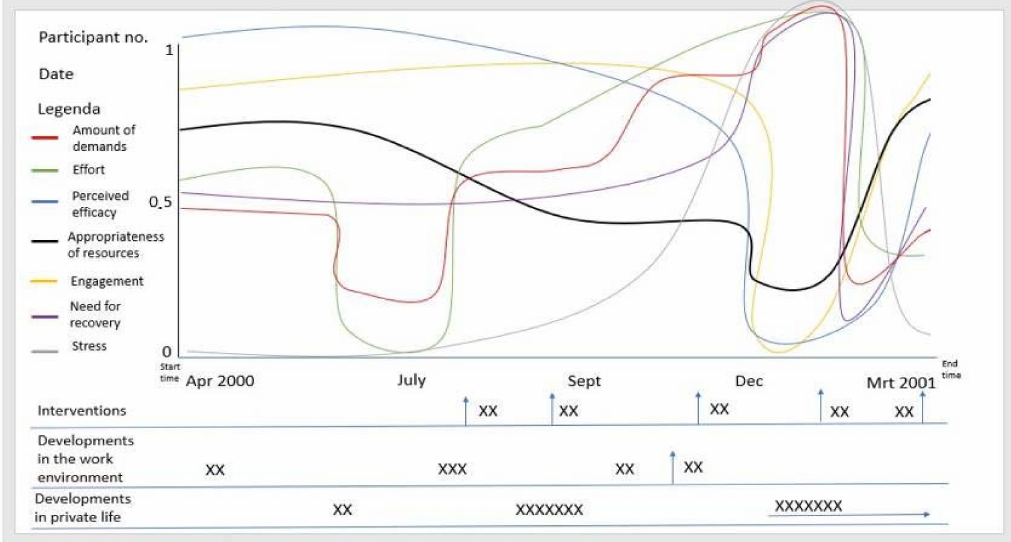
Figure 5. The response from one of the participants (digitalized with Microsoft PowerPoint). The top section shows the graphs of the seven perceived variables (amount of demands, e ff ort, perceived e ffi cacy, appropriateness of resources, engagement, need for recovery, stress responses) sketched by the participants. The bottom section shows the three timelines (from-top-to-bottom: interventions, developments in the work environment, developments in private life). The actual responses included notes on the